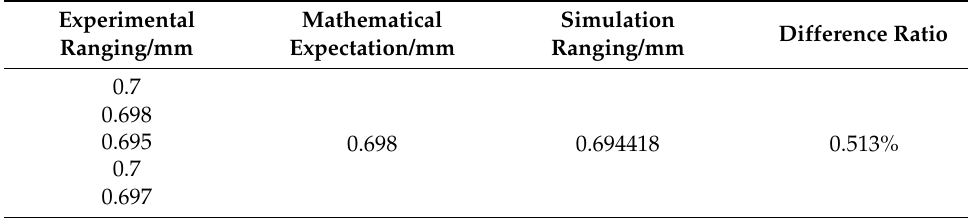
Figure 13. ( a ) Experimental schematic; ( b ) ranging before bending (units shown in µ m); ( c ) ranging after bending (units shown in µ m). Table 7. Comparison of ranging